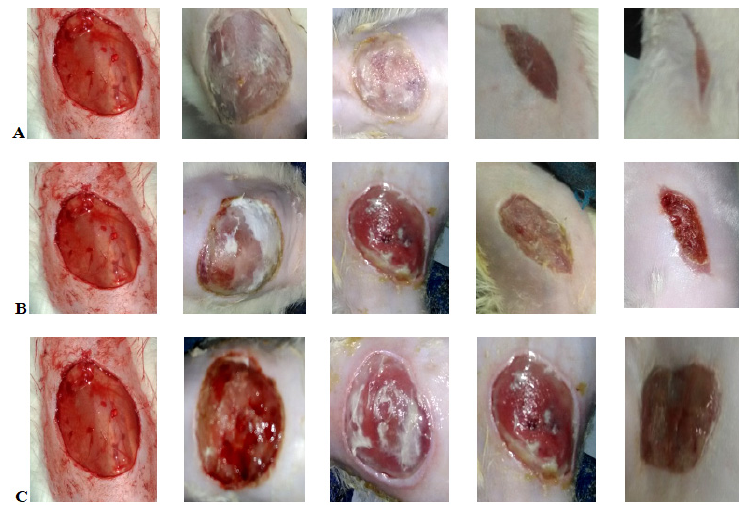
Figure 4. Effect of EOLS cream formulation treatment on rate of wound contraction in rats. Table 4. Wound healing processes and healing phases of the vehicle, EOLS cream, and Madecassol ® administered to rats.